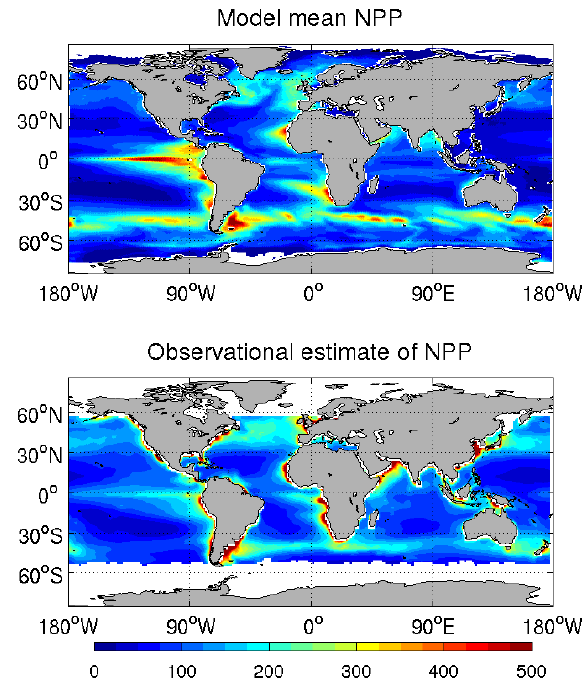
Fig. 10. Model simulated (top) and observed (bottom) annual mean of surface net primary production. The observation estimate is based on remotely sensed chlorophyll data and the Vertically General- ized Production Model (VGPM) from Behrenfeld and Falkowski (1997). Model value is taken from HIST simulation over 1996– 2005 period, whereas the data is from 2003–2007 period. Units are in (gCm − 2 yr − 1